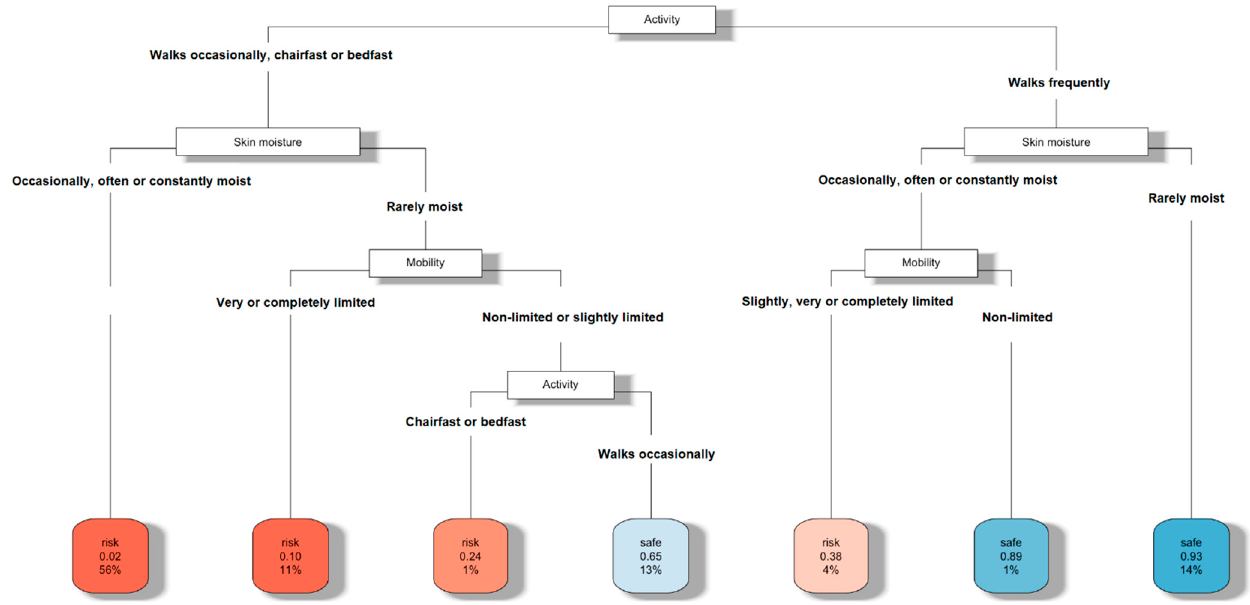
Figure 2. Decision tree for PU risk assessment based on activity, mobility and skin moisture.